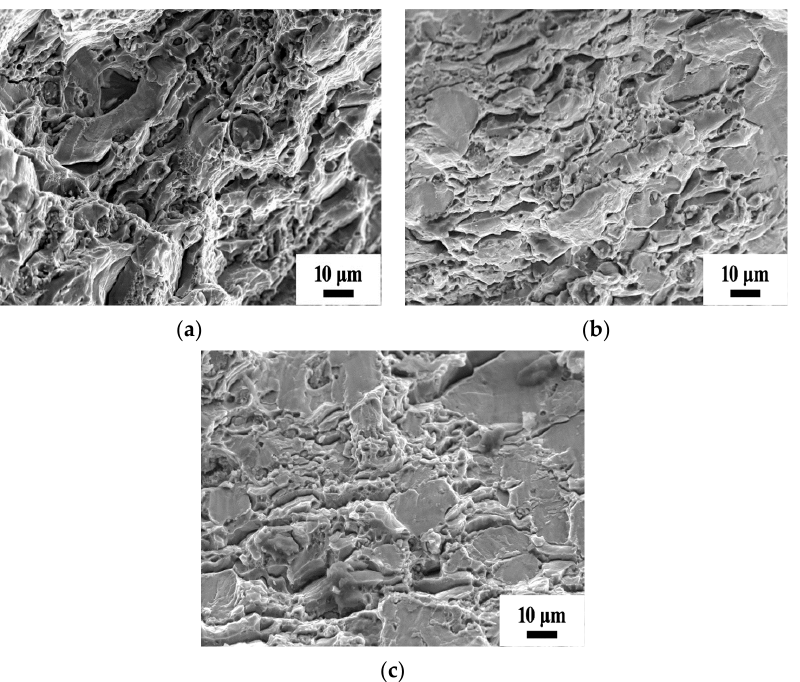
Figure 9. Tensile fracture morphology of the alloy in solid solution + aging at − 30 °C: ( a ) solution + aging 18 h; ( b ) solution + aging 24 h; ( c ) solution + aging 36 h.